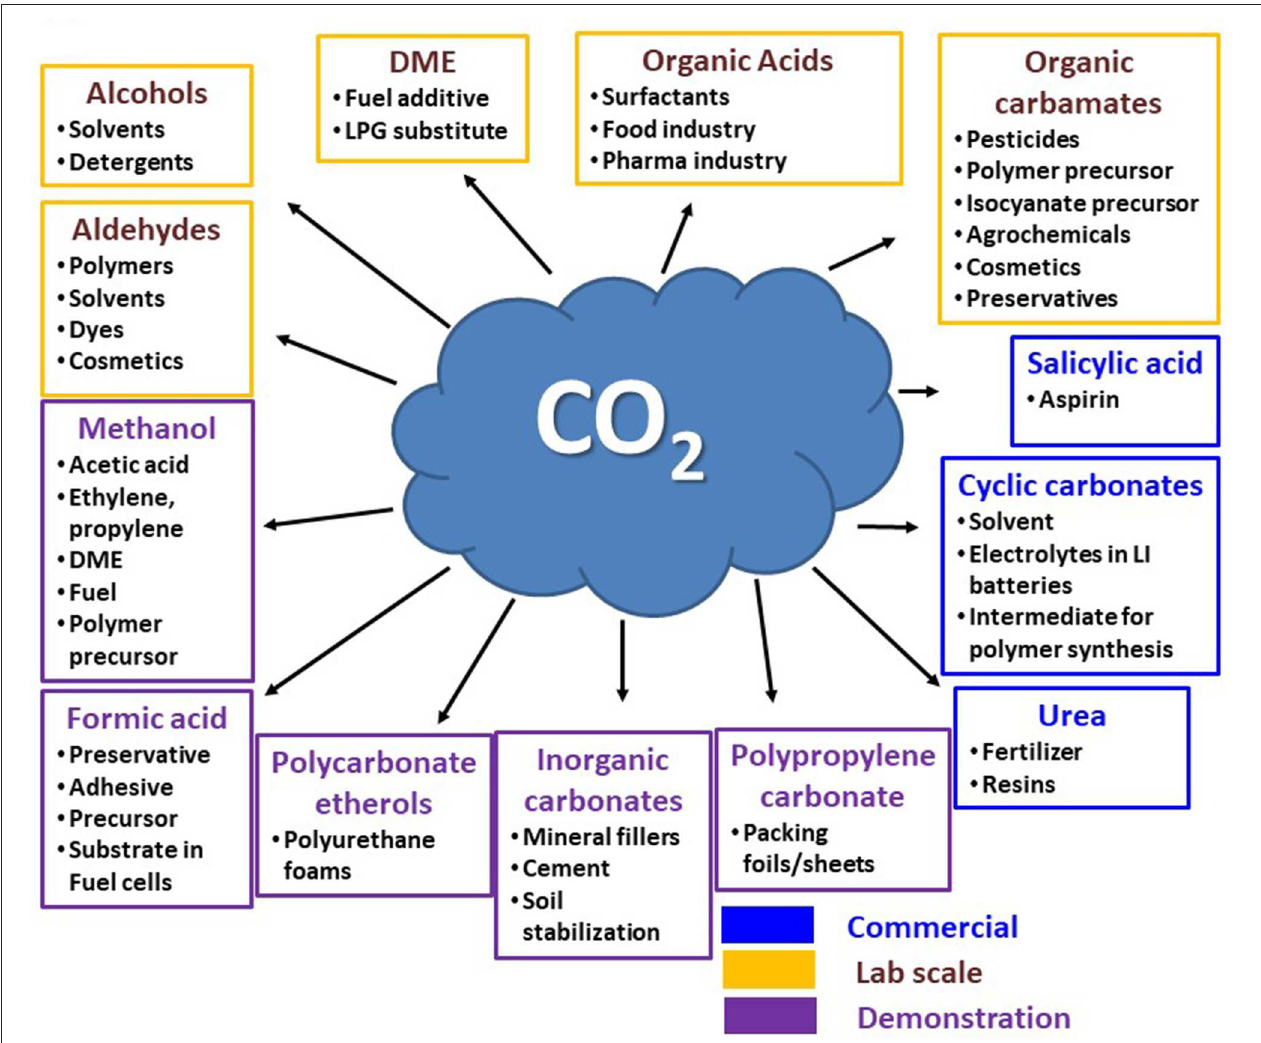
FIGURE 6 | CO 2 conversion to target products and their position of implementation. Redrawn from (Bioenergy, IEA – 2020; ISBN 978-1-910154-69-4).